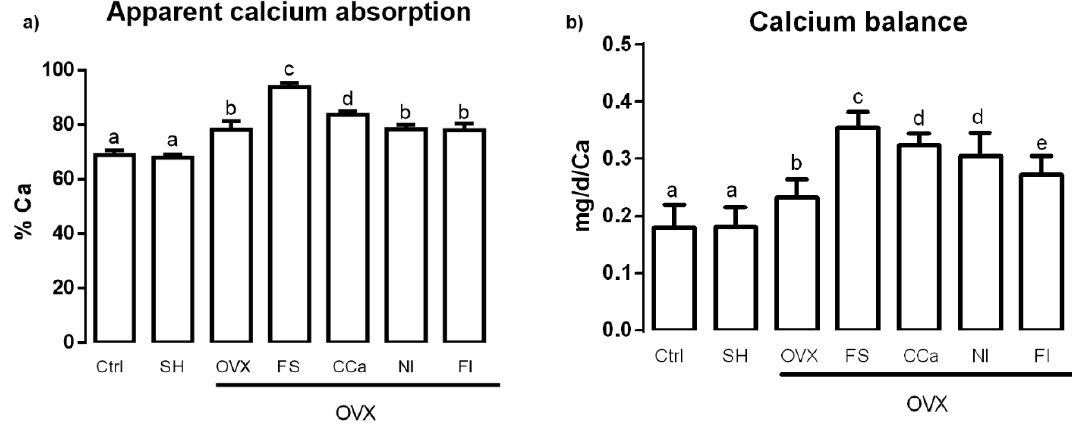
Figure 2. ( a ) Apparent calcium absorption and ( b ) calcium balance in experimental groups. The results represent the average ± SD of experimental groups, n = 5 rats / group. Means in bars with di ff erent letters indicate significant di ff erences ( p ≤ 0.05) between groups with Tukey’s test. Ctrl = control group, SH = sham group, OVX = ovariectomized group fed with AIN-93M, FS = ovariectomized group fed with diet supplemented with soluble fiber extracted from O. ficus-indica , CCa = ovariectomized group fed with diet supplemented with calcium citrate, NI = ovariectomized group fed with diet supplemented with O. ficus-indica powder, FI = ovariectomized group fed with diet supplemented with insoluble fiber extracted from O. ficus-indica . Table 3. Physical and mechanical properties of femoral bone in rats fed with the experimental diets. Parameters